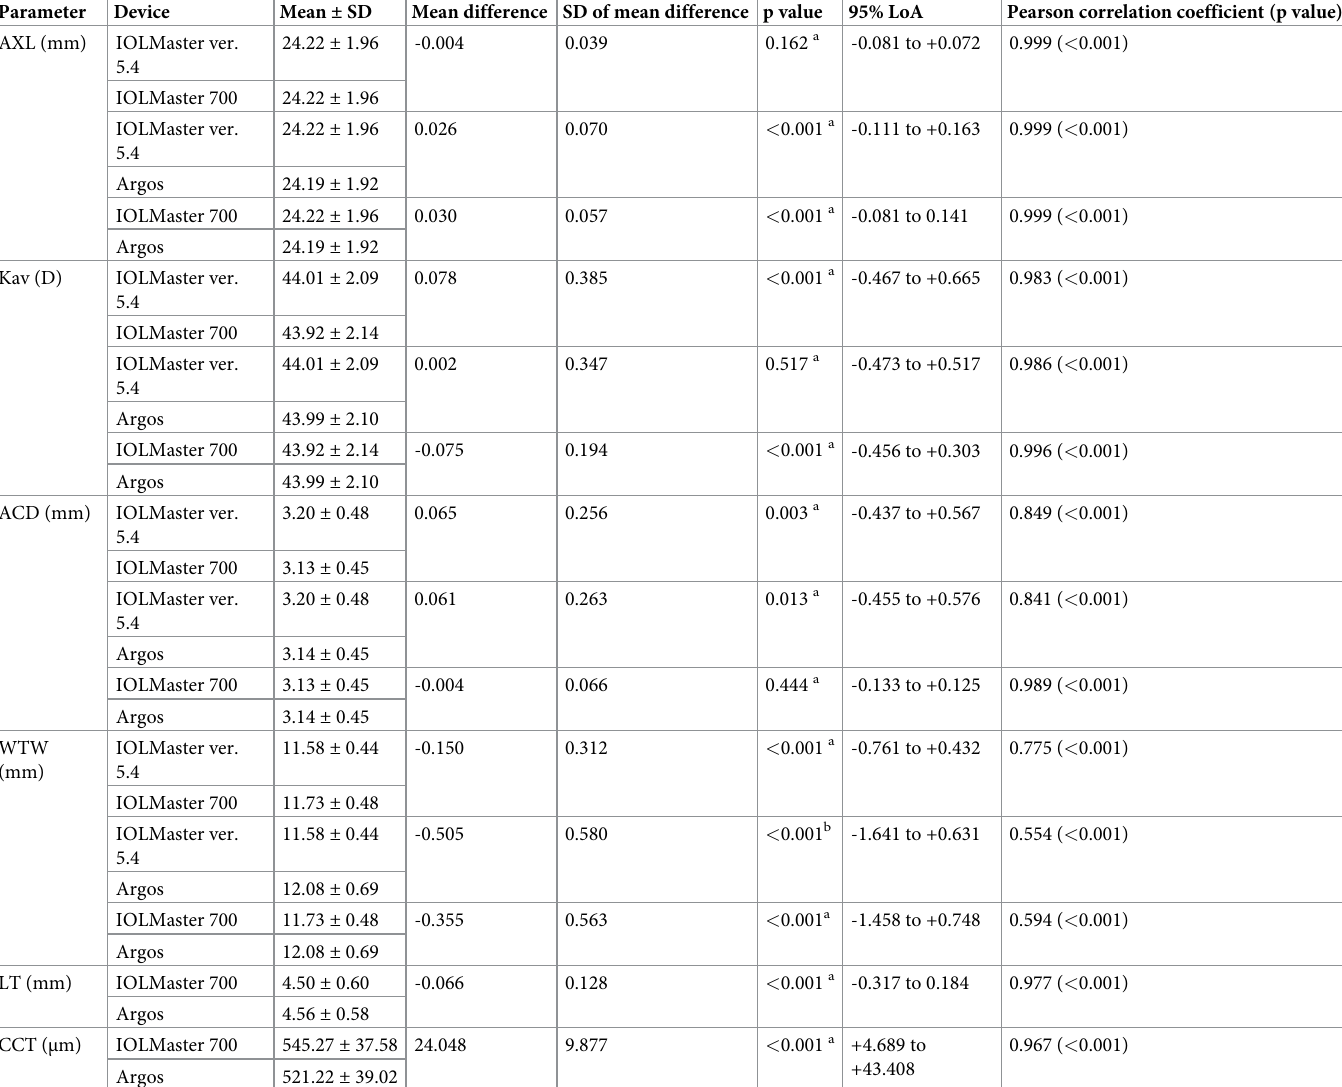
Table 1. Summary of the comparison of values measured by the three